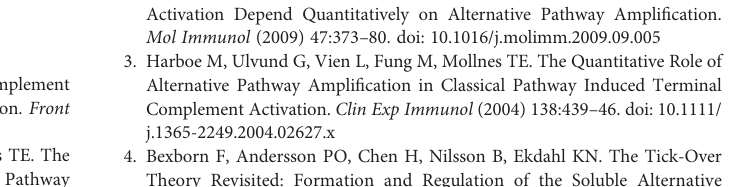
phenix.table_one. Supplementary Figure 1 | Crystal structure of the EWE:C3b. (A) Cartoon representation of the overall structure of EWE (orange) in complex with C3b (green). (B) Zoom on the N-terminus of EWE displaying the 2mF o -DF c map contoured at 1 s . Labels indicate the positions of glutamine 4 in EWE and the MG6 domain of C3b. Supplementary Figure 2 | Analyses of the parental hC3Nb1. (A) Non-reducing SDS-PAGE of peakfractionsfrompanels H-J. Mass spectrometricanalyses of (B) bacterially expressedhC3Nb1, (C) bacteriallyexpressed hC3Nb1 (W102A), (D) mammalian expressedhC3Nb1, (E) bacterially expressedhC3Nb1(Q1N), and (F) bacteriallyexpressedhC3Nb1( D Q1).BLIbasedanalysesbindingto50nMnativeC3or 50nMC3bby (G) bacteriallyexpressedEWEandhC3Nb1, (H)